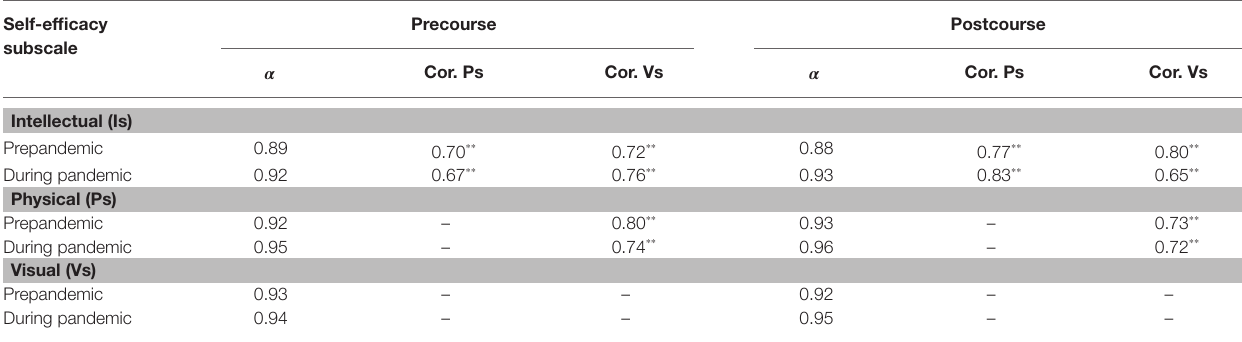
TABLE 4 | Reliability and internal consistency of the self-efficacy scale.